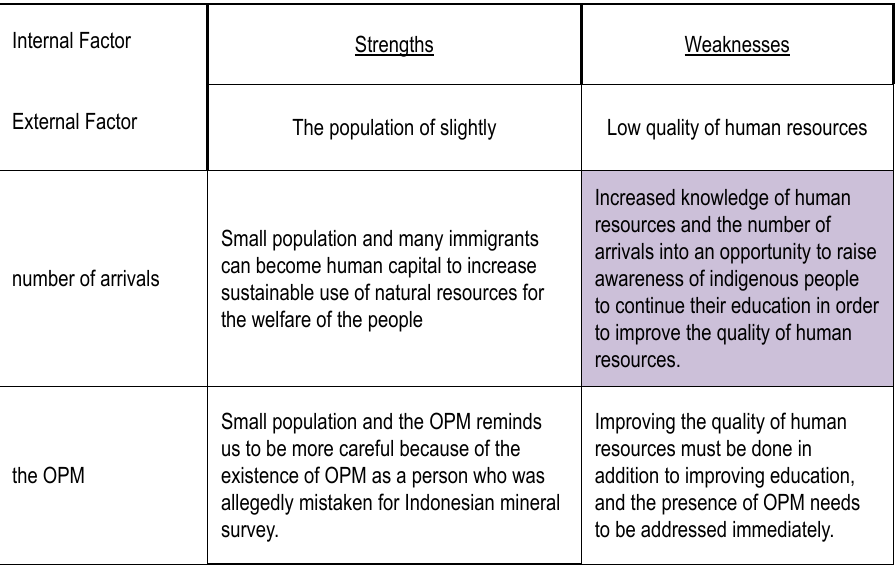
Table 2. Strategy Formulation SWOT Case Papua Internal Factor